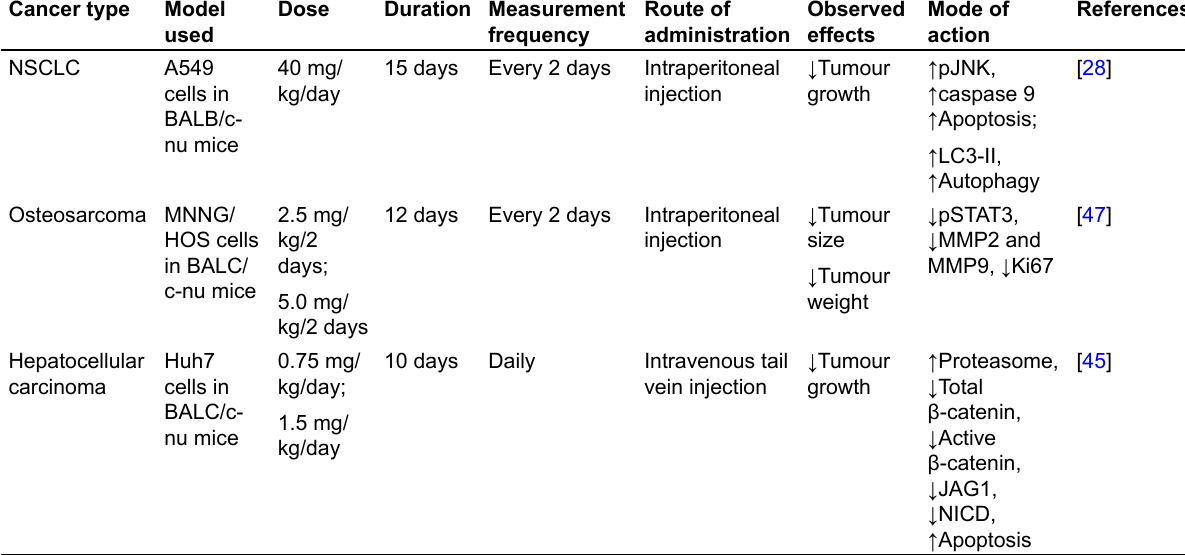
Table 2. Details of the anticancer efficacy of BD in several human malignancies using in vivo models Cancer